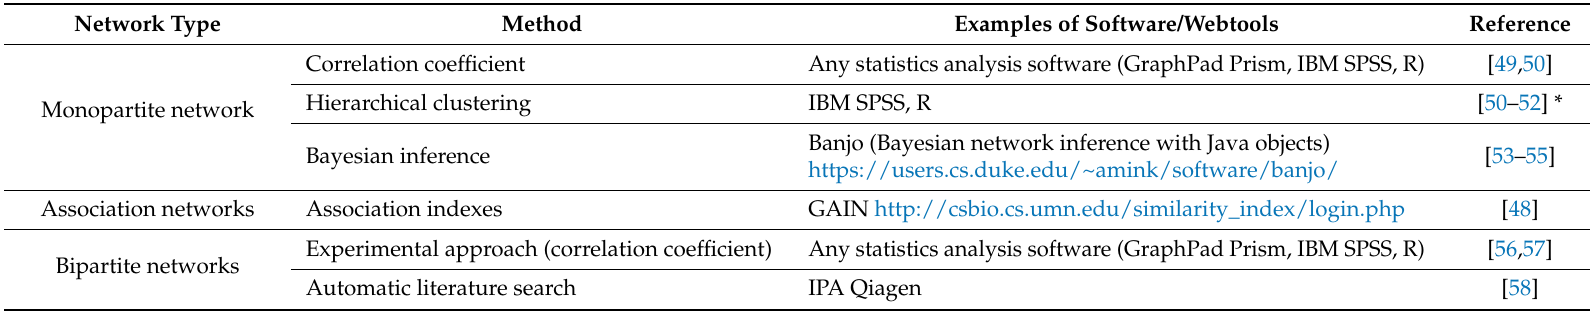
Table 2. Useful software and webtools to generate monopartite, association and bipartite